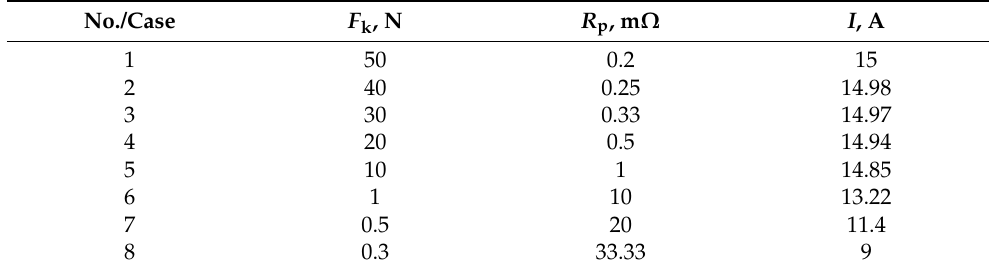
Table 1. Calculated contact resistance values R p depending on the contact force F k